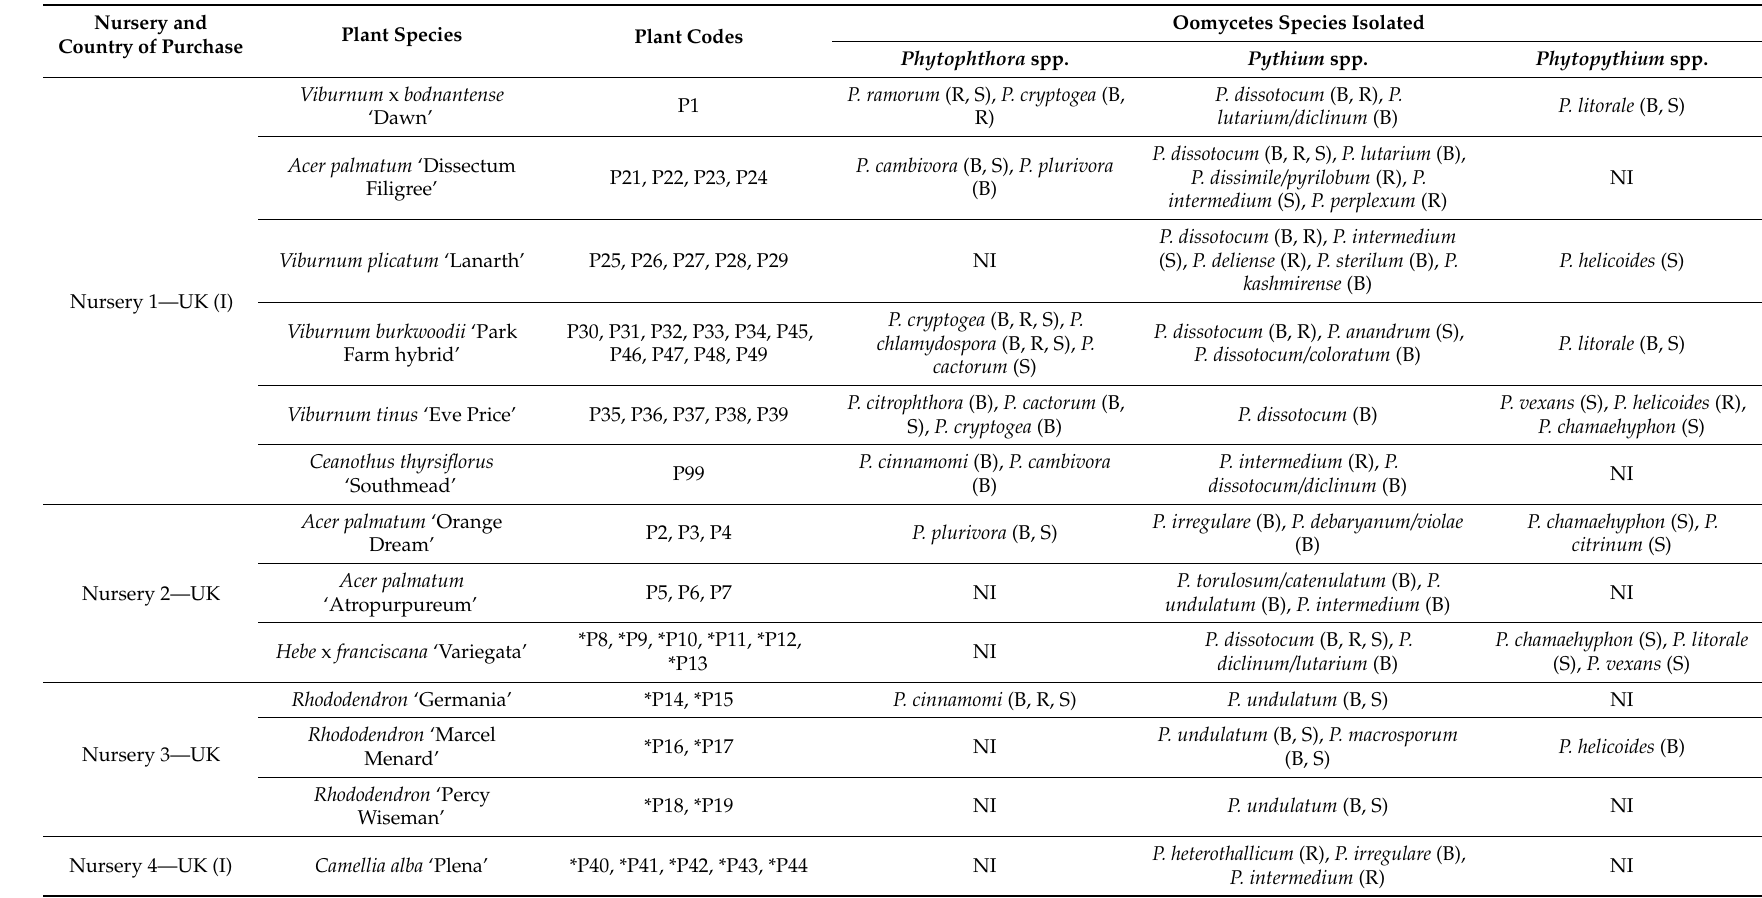
Table 2. Plant species analysed, with oomycetes isolated using classical